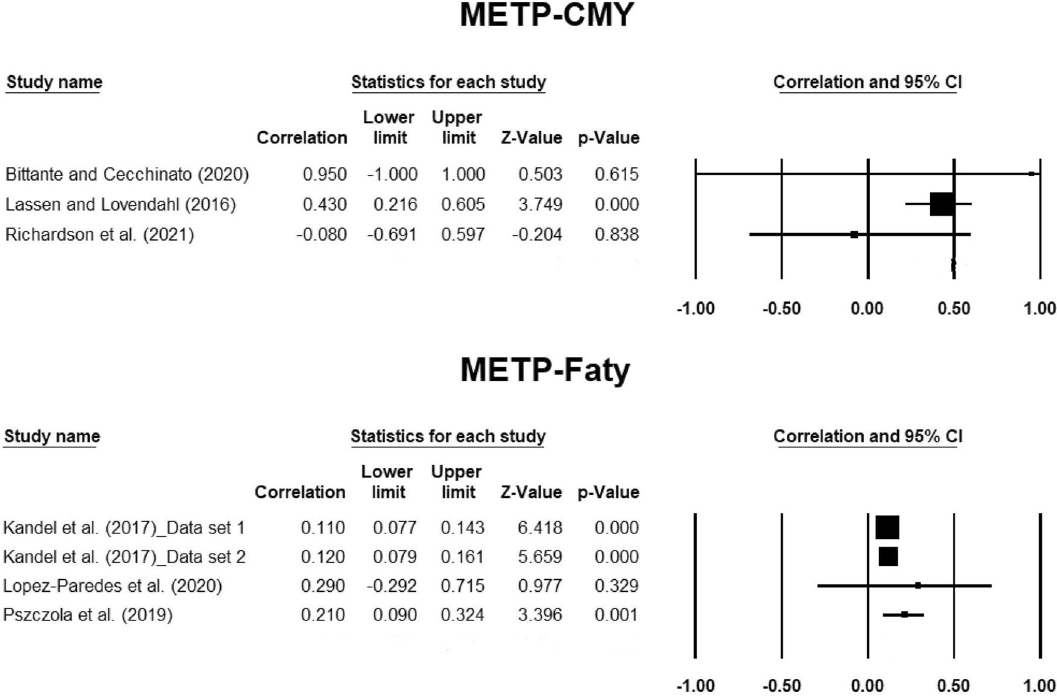
Figure 3. The forest plots of individual studies for the genetic correlation estimates between METP with CMY and Faty in dairy cows. Details are provided in Fig.